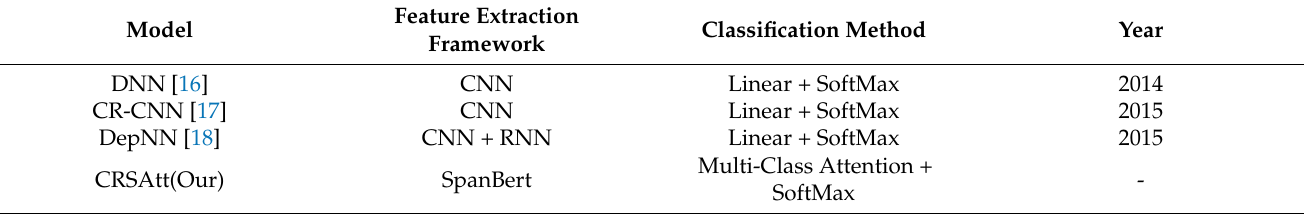
Table 1. Summary of our model and the convolutional-neural-network-based models.